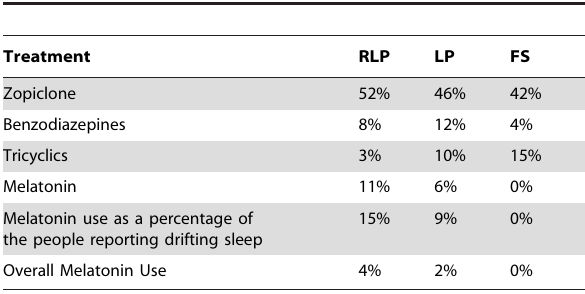
Table 6. Sleep medications prescribed to people presenting to their General